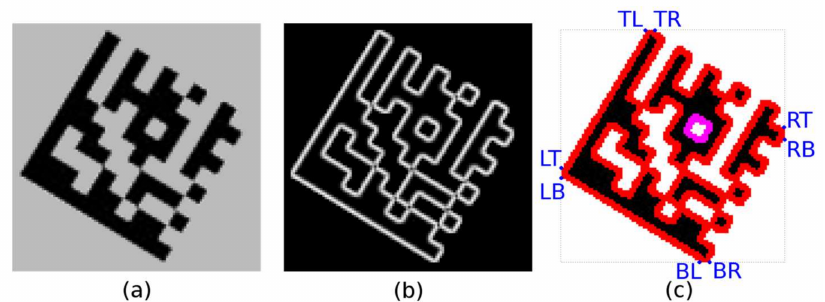
Figure 6. ( a ) grayscale image; ( b ) edge image (magnitudes); ( c ) colored continuous edge regions.